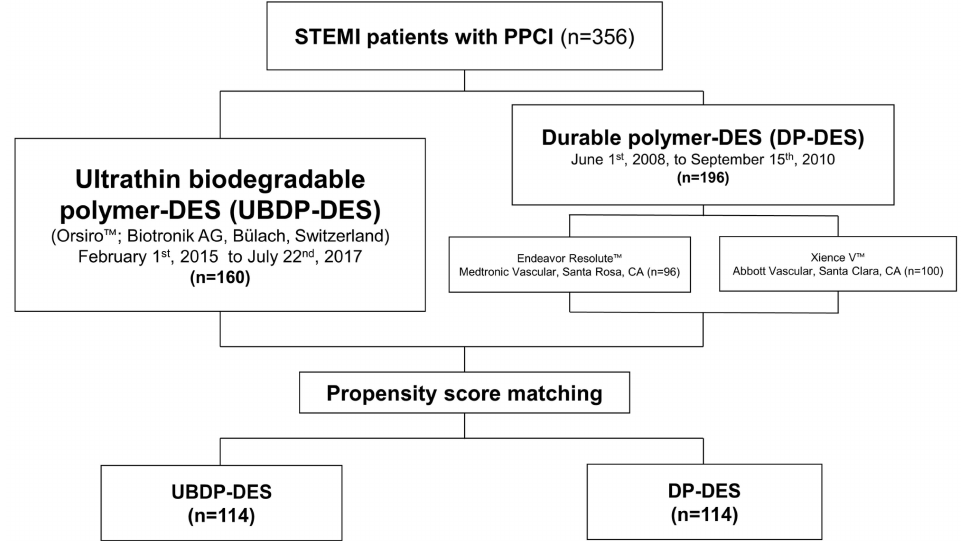
Figure 1. Diagram of the study